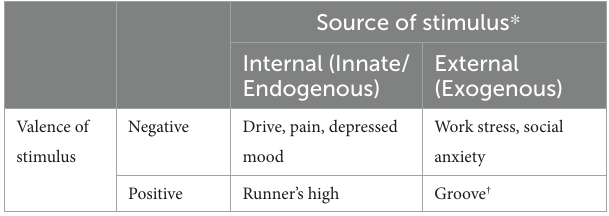
TABLE 2 Examples of sensations of tension that may result in physical